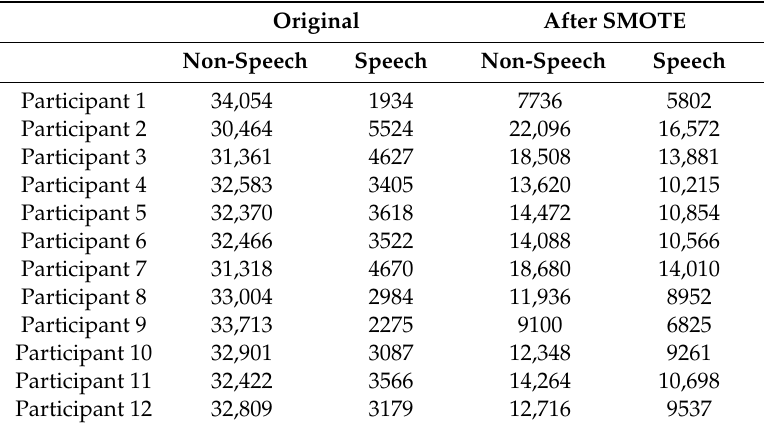
Table 2. Number of speech and non-speech samples (each corresponding to 0.1 s time segment) for the twelve